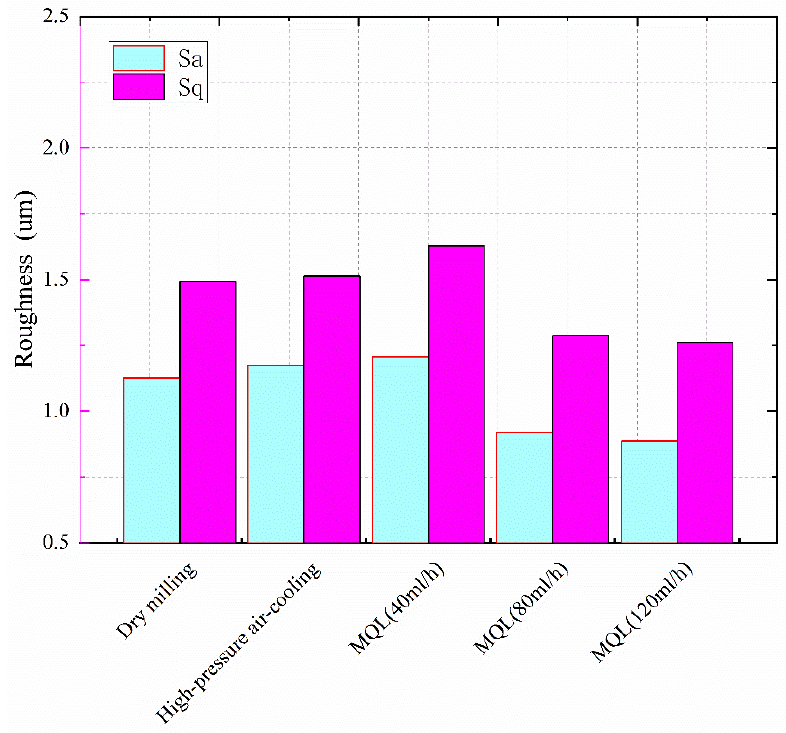
Figure 19. The trend of the roughness of the milled surface with the lubrication parameters.